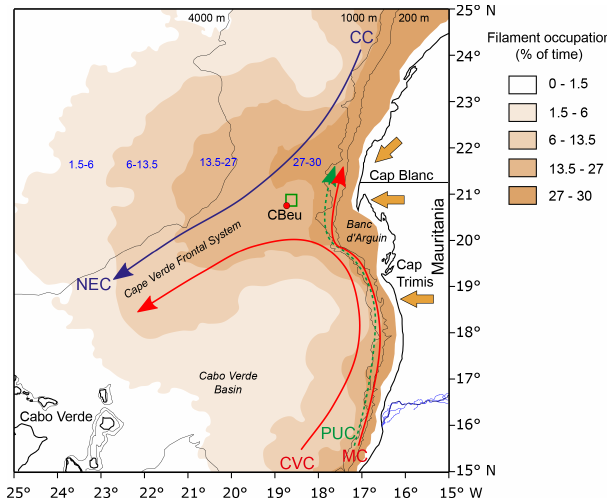
Figure 1. The Mauritanian upwelling system. CC, Canary Cur- rent; NEC, North Equatorial Current; CVC, Cap Verde Current; MC, Mauritanian Current; PUC, Poleward Under Current. The red circle in the lower left corner of the small green square marks the lo- cation of mooring CBeu. The green square represents the upstream 0.25 ◦ × 0 . 25 ◦ area from which sea surface data have been obtained. (cid:48) (Prahl and Wake- proxy: the long-chain-alkenone-based U K 37 ham, 1987; Brassell et al.,